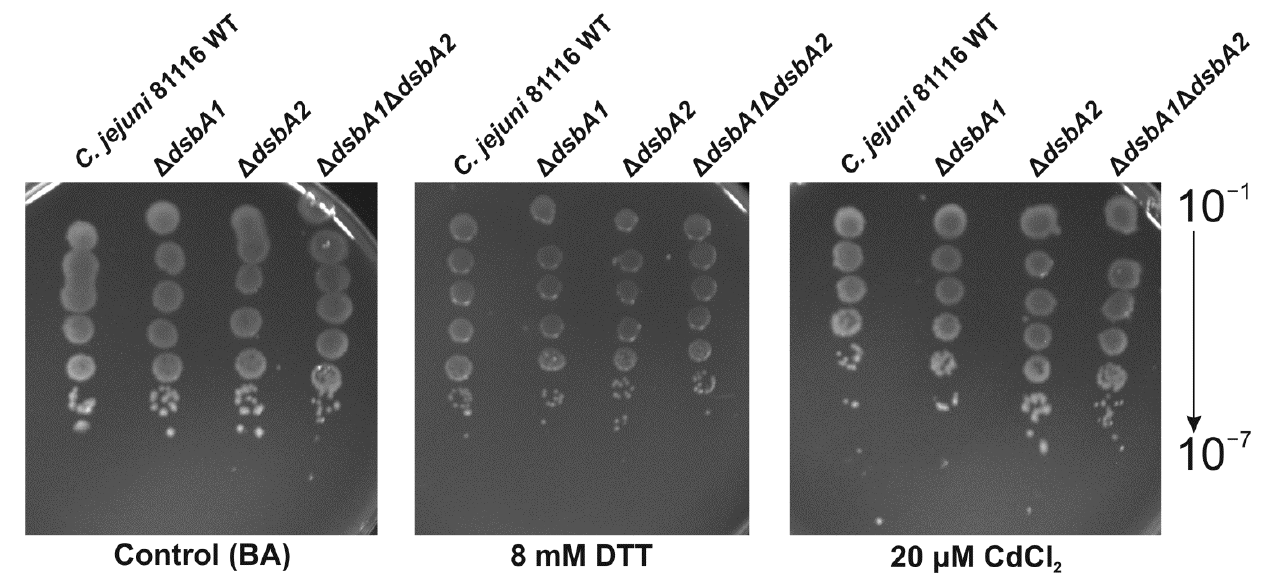
Figure 3. C. jejuni 81116 cells deficient in cjdsbA1 or cjdsbA2 or both cjdsbA1 and cjdsbA2 were not sensitive to reducing agent DTT or cadmium chloride. Serial ten-fold dilutions of C. jejuni 81116 strains in exponential growth phase were spotted onto BA plates supplemented with 8 mM DTT or 20 µ M CdCl 2 and incubated for 48 h at 37 ◦ C under microaerophilic conditions. Three independent experiments were performed ( n = 3). The figure presents a representative result.